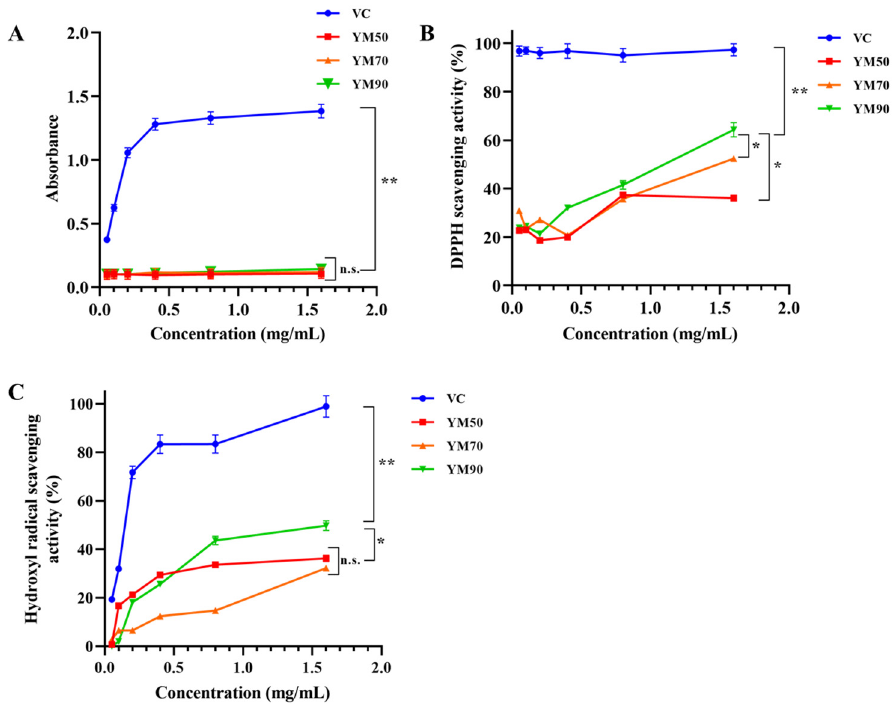
Figure 4. Scavenging effect on reducing power ( A ), DPPH free radical ( B ), and hydroxyl radical ( C ) of mannans at different concentrations. Vitamin C was used as positive control. All analyses were carried out in triplicate, and * p < 0.05, and ** p < 0.01, n.s.: no significant difference.